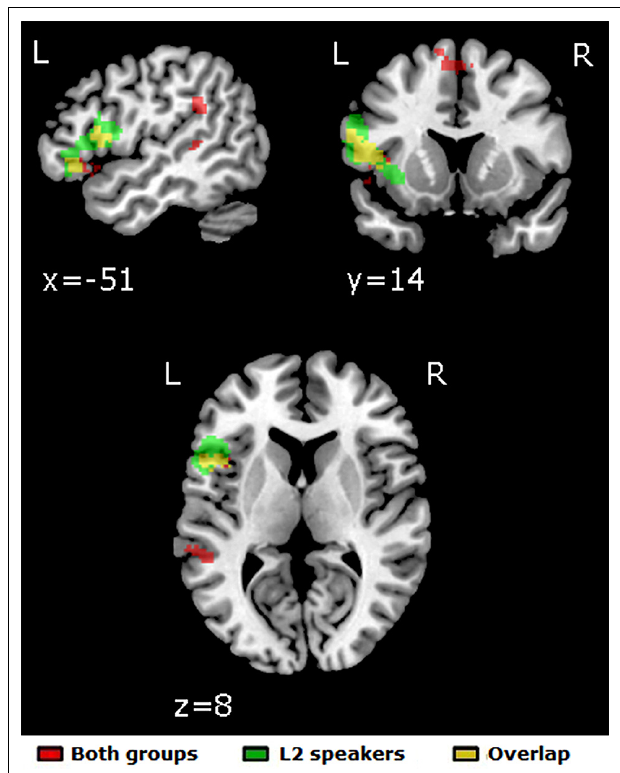
FIGURE 2 | Significant clusters of activation for the [Unprimed – Primed] contrast in the full-factorial whole-brain analysis. Red: both groups; green: L2 speakers; yellow: overlap between activations for both groups and for L2 speakers. p < 0.005/k > 65, leading to a correction for multiple comparisons of p < 0.05. No significant activation was found for L1 speakers for this contrast.